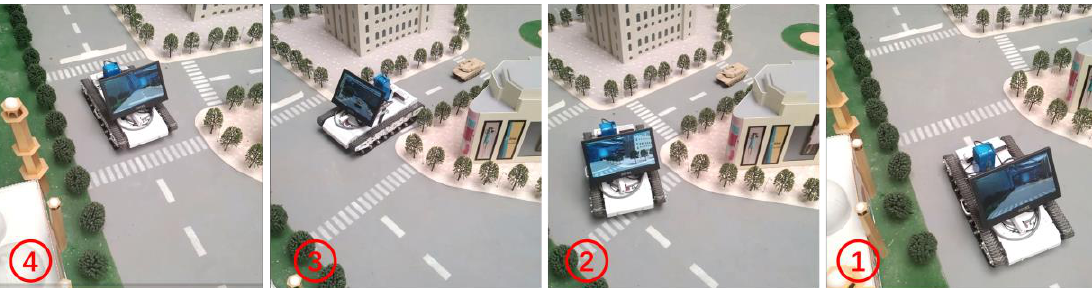
Figure 12. Illustration of the car in different locations. Images 1, 2, 3, and 4 show the position of the car at different moments, respectively.